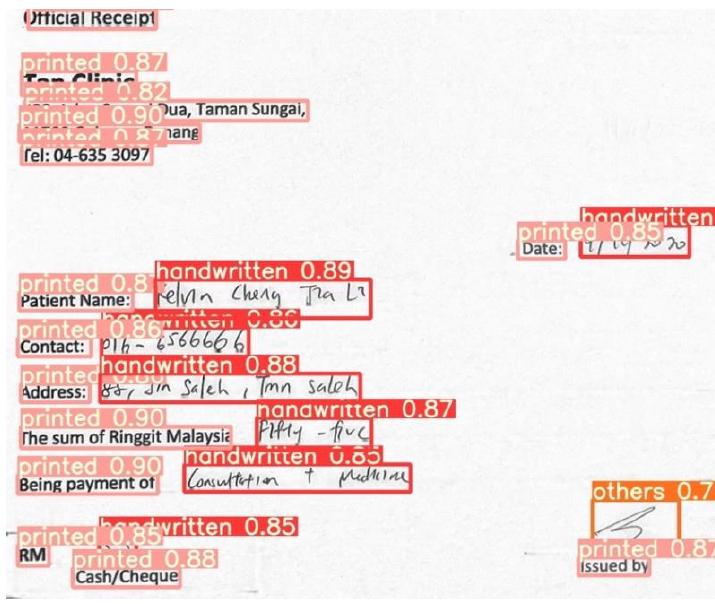
Figure 8. Sample detected output of the YOLOv5 model.